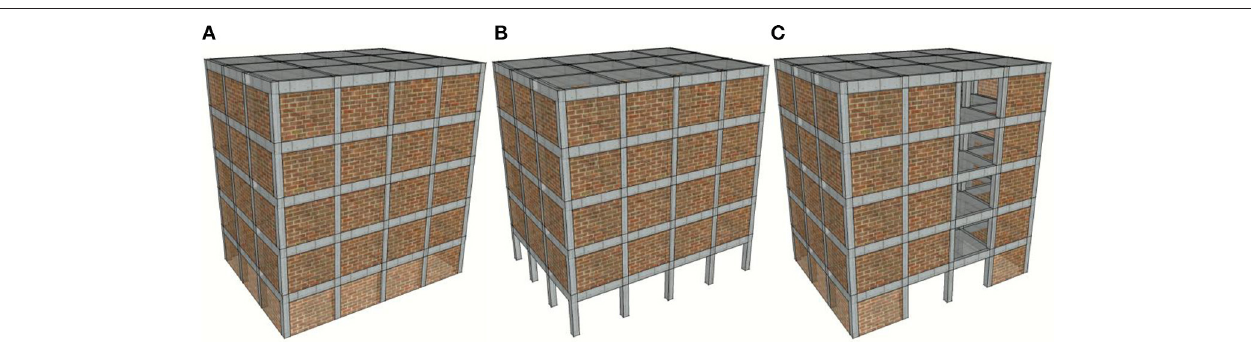
FIGURE 1 | Selected building forms of the 60 and 70s.